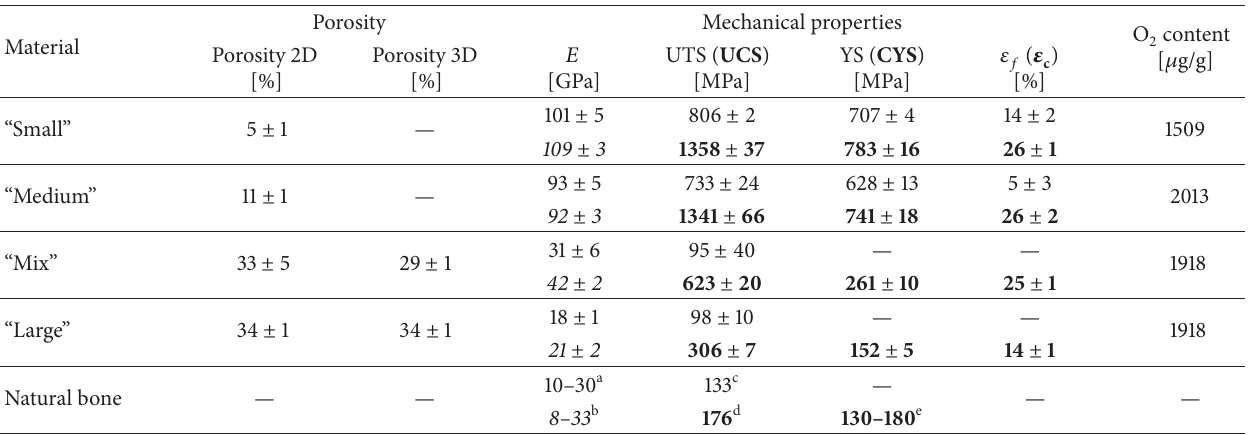
Table 1: Material properties, mechanical properties, pore volumes, and oxygen contents of the different porous TiAl6V4 materials. The results of tensile, compression, and resonant ultrasound spectroscopy (RUS) tests are displayed in Roman, bold, and in italic fonts, respectively. Porosity Material